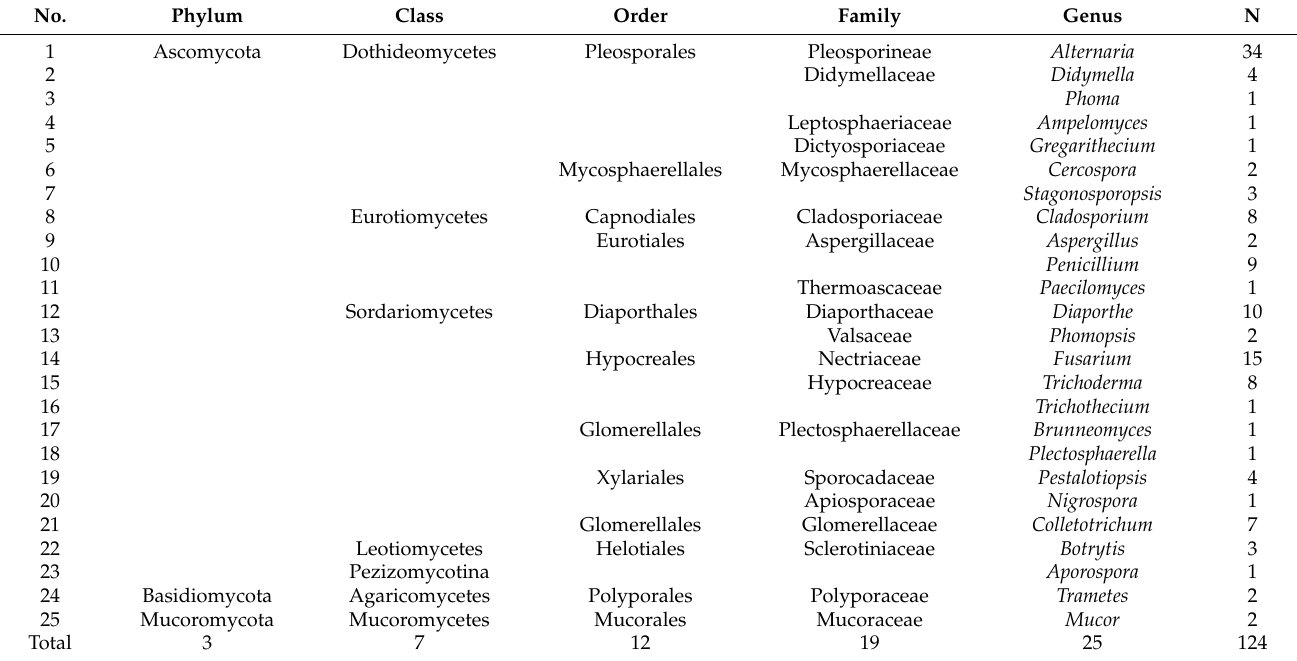
Table 2. Taxa of culturable endophytic fungi isolates from A. adenophora